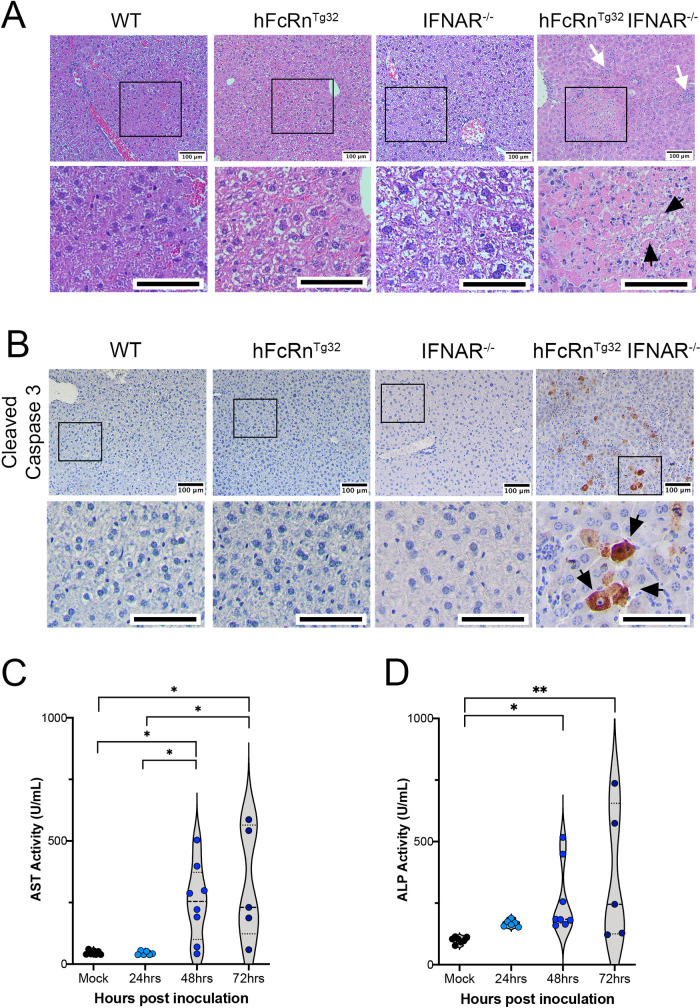
E11 infection induces histopathologic changes and cell death.C57Bl/6 (WT), hFcRnTg32, IFNAR-/-, and hFcRnTg32-IFNAR-/- adult mice were IP inoculated with 104 E11 and sacrificed 72 hours post inoculation. (A) H&E staining of the livers in adult mice. White arrows denote immune cell infiltration and black arrows denote areas of hepatocytolysis. (B) Immunohistochemistry using an antibody recognizing the cleaved form of caspase 3 from the livers of a representative animal of each genotype as indicated. Black arrows denote positive staining. Scale bars (100μm) are shown at bottom right. Aspartate transaminase (AST) (C) or alkaline phosphatase (ALP) (D) levels in the serum of adult mice IP inoculated with 106 E11 and sacrificed at designated time shown. Data are shown with significance determined with a Kruskal-Wallis test with a Dunn’s test for multiple comparisons (*p<0.05, **p<0.005).